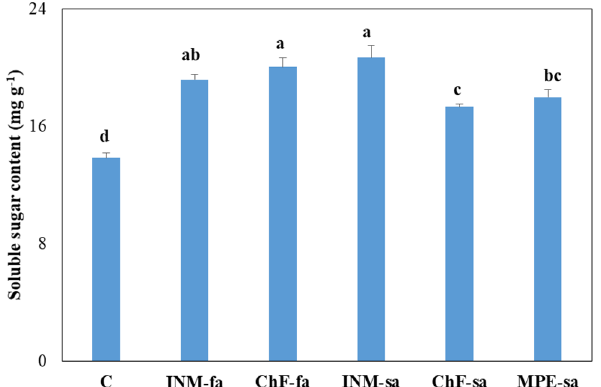
Figure 5. Effect of fertilization through different (root/foliar) application methods on leaf soluble sugar content of Origanum microphyllum . C: control (water); INM: integrated nutrient management (INM) by foliar (INM-fa) or soil application (INM-sa); ChF: conventional fertilization by foliar (ChF-fa) or soil application (ChF-sa); MPE-sa: mixture of plant extracts as biostimulant by soil application. Soluble protein content was expressed per fresh weight basis. Values represent the mean of three replicates ± SEM. Within each plot different letters indicate significant differences.